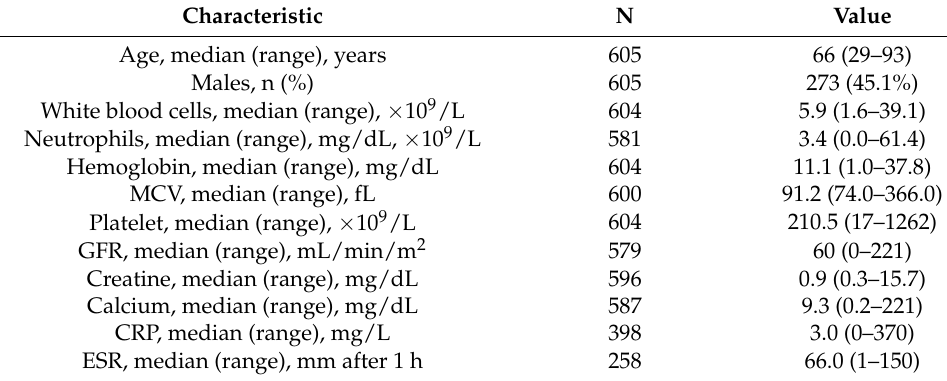
Table 1. Characteristics of screening design phase participants (n = 605).